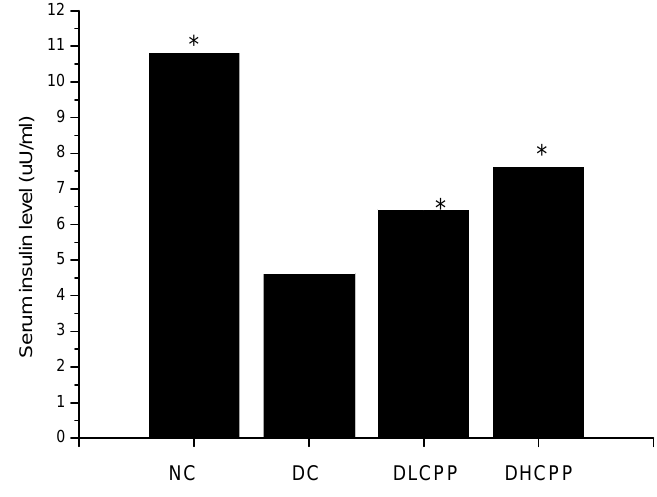
Figure 1. Effect of CPP on serum insulin level in